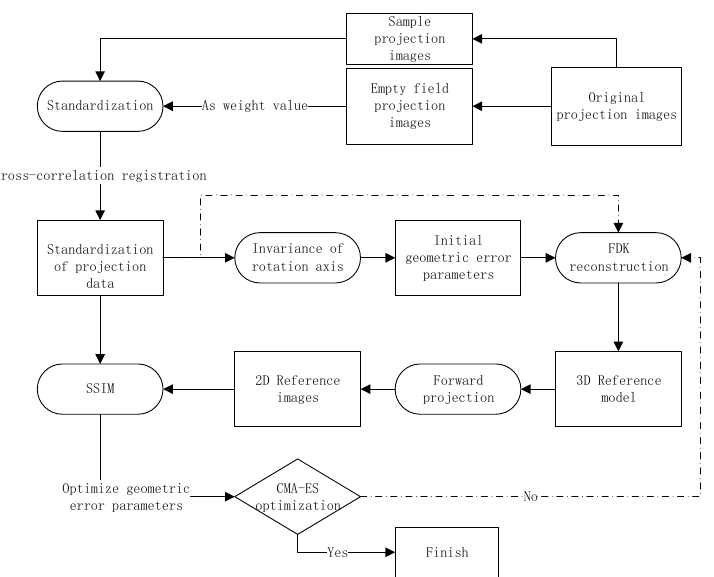
Figure 2. Flowchart of the self-calibration